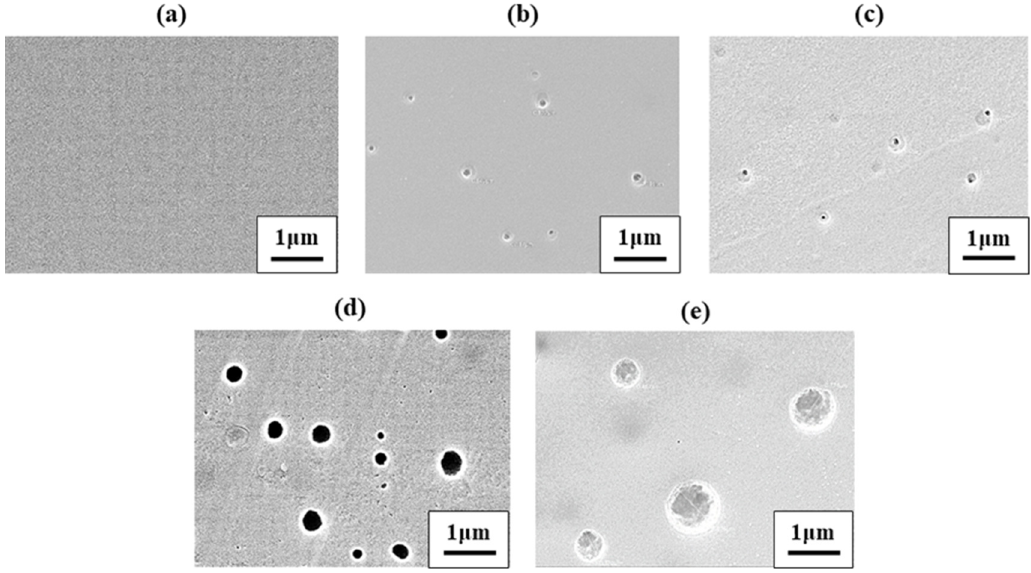
Figure 7. SEM images of micropores in the CPI membrane films with 6FAm-OH containing ( a ) 0, ( b ) 0.5, ( c ) 1.0, ( d ) 2.0, and ( e ) 5.0 wt% PVA. ( c ) 1.0, ( d ) 2.0, and ( e ) 5.0 wt% PVA.